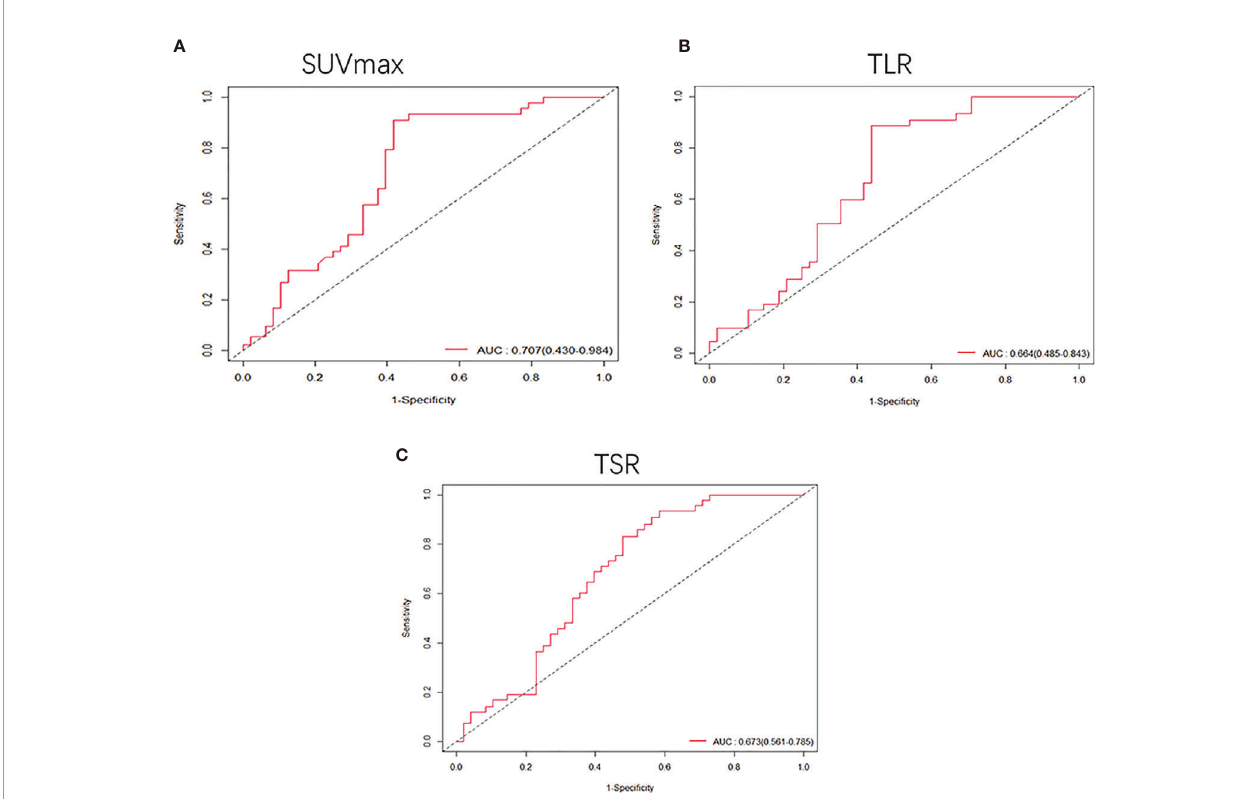
FIGURE 4 | Receiver operating characteristic (ROC) curves were used to compare the SUVmax (A) , TLR (B) and TSR (C) of patients whose tumor size was smaller than 3 cm. The AUCs were 0.707 (95%CI, 0.430-0.984) for SUVmax, 0.664 (95%CI, 0.485-0.843) for TLR and 0.673 (95%CI, 0.561-0.785) for